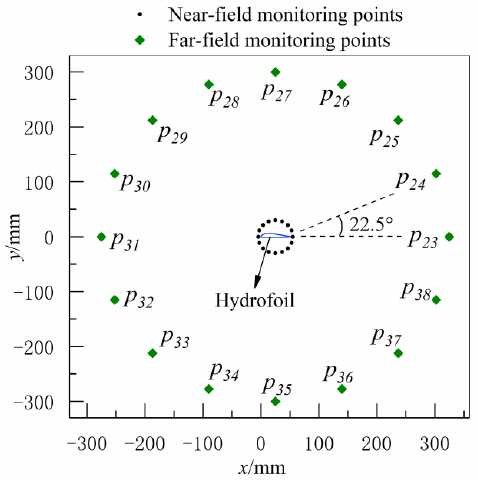
Figure 19. Observing points for the far-field SPL computation with 16 locations.